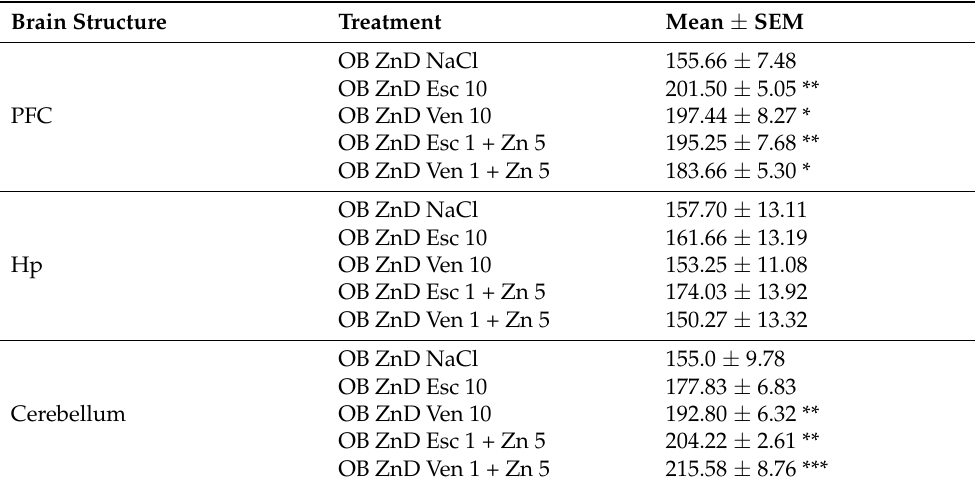
Table 4. The effects of antidepressants and Zn supplementation on synaptic zinc level in rats subjected to the OB + ZnD model using Timm staining.